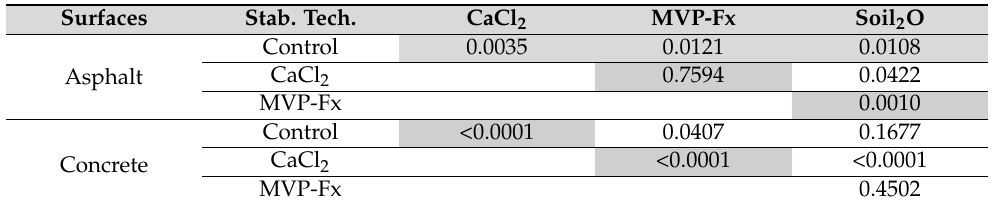
indicates a significant difference ( p <